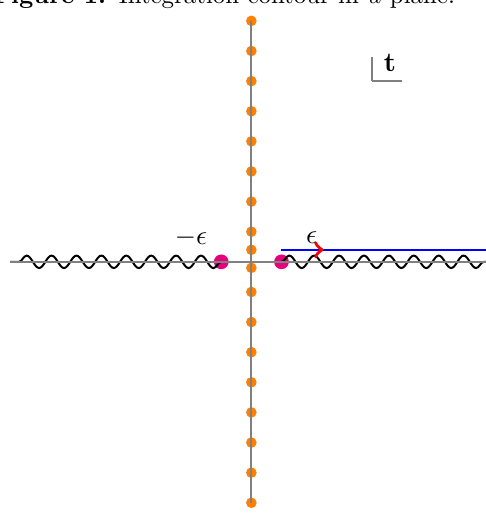
Figure 1. Integration contour in u -plane.